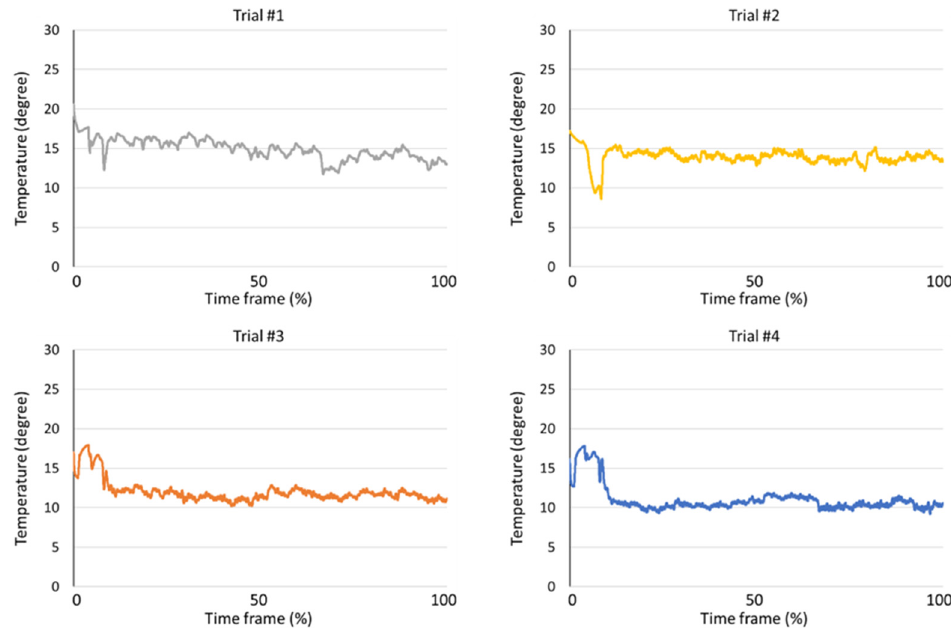
Figure 4. Real-time cold chain temperature condition for measurement of egg freshness.